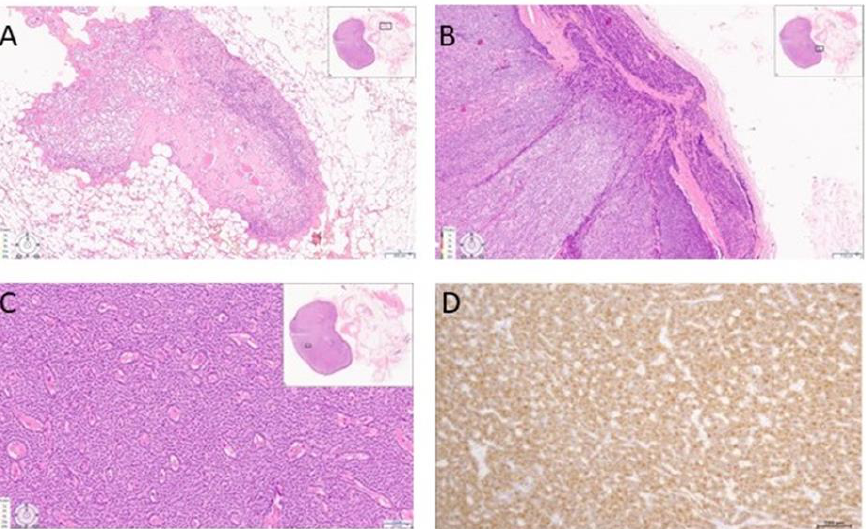
Figure 4. Microscopic examination of the recurrent parathyroid cancer and papillary thyroid cancer metastasis. ( A ) Metastasis of the follicular subtype of papillary thyroid cancer to a lymph node. Subtotal replacement of lymph node tissue; ( B ) Metastatic nodule of parathyroid cancer with signs of invasion; ( C ) Pattern of microscopic structure of parathyroid cancer metastasis with single mitotic figures; ( D ) Parathyroid cancer metastasis cells are positive for PTH.